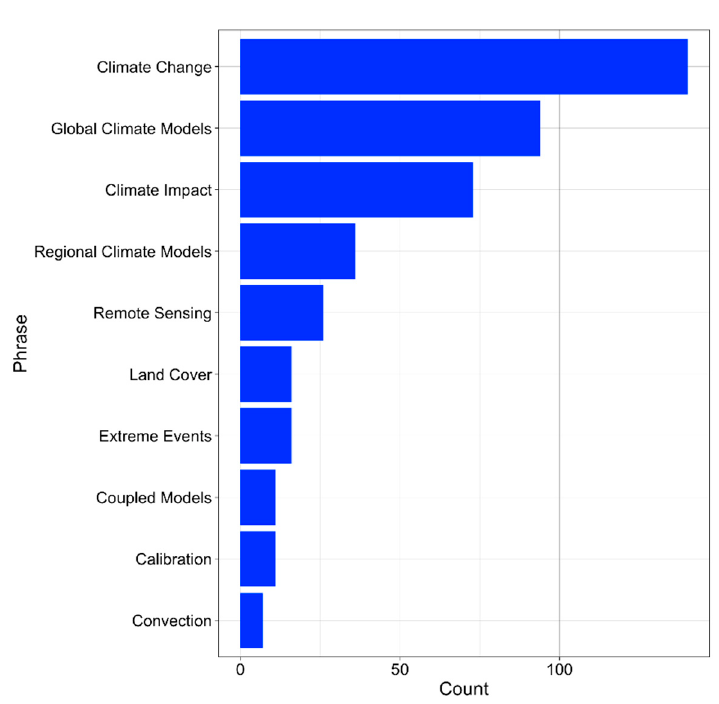
Figure 3. Most common phrases from articles related to climate and machine learning.